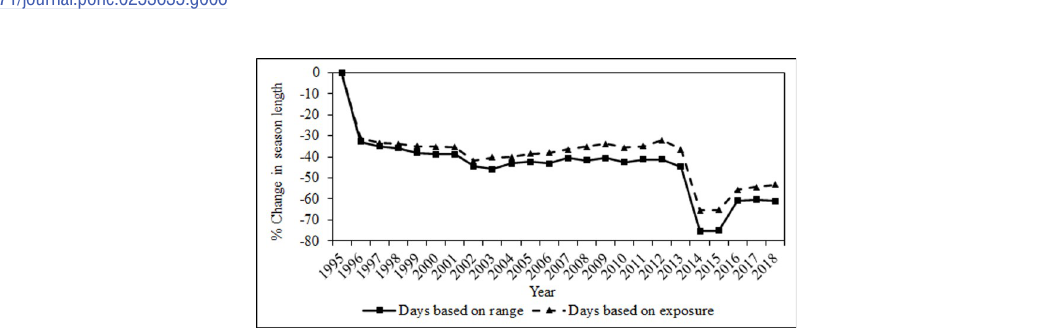
PLOS ONE | https://doi.org/10.1371/journal.pone.0253635 October 5,